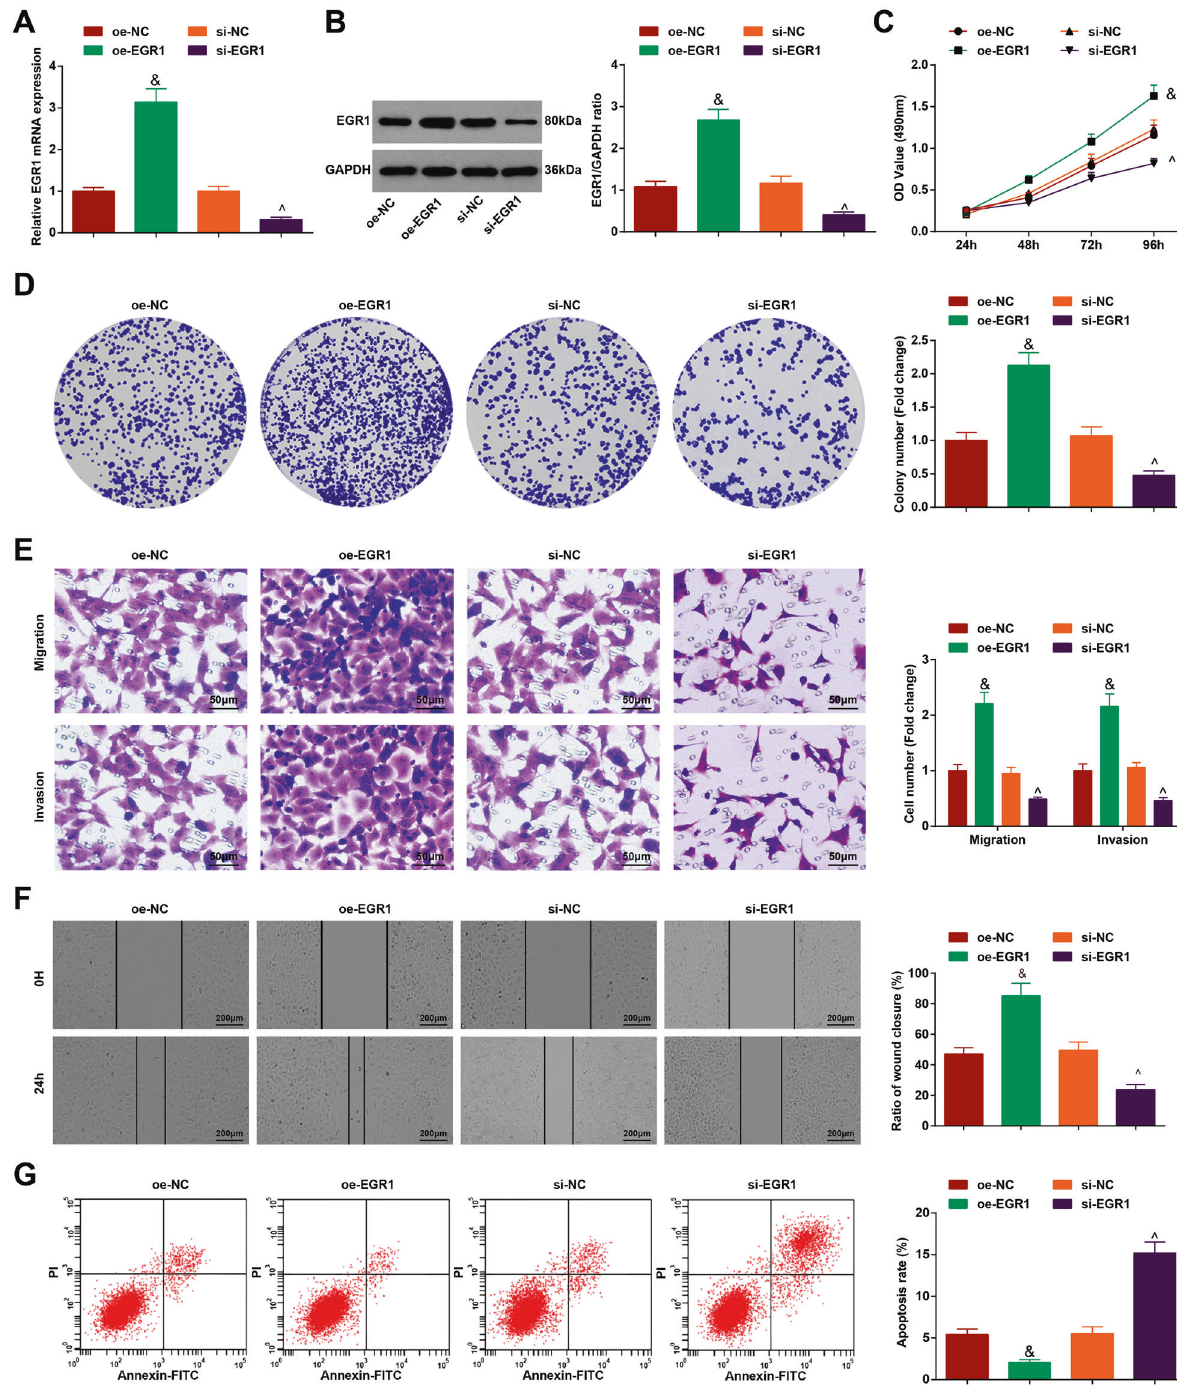
Fig. 4 Silencing EGR1 inhibits HCC progression. A, B EGR1 expression in HCC cells tested by RT-qPCR and western blot analysis after upregulating or downregulating EGR1; C OD value tested by MTT test after upregulating or downregulating EGR1; D Colony-forming ability of HCC cells tested by colony formation assay after upregulating or downregulating EGR1; E Migration and invasion of HCC cells tested by Transwell test after upregulating or downregulating EGR1 (scale bar = 50 μ m); F Migration distance of HCC cells tested by scratch test after upregulating or downregulating EGR1 (scale bar = 200 μ m); G Apoptosis of HCC cells tested by fl ow cytometry after upregulating or downregulating EGR1. N = 3. The data were expressed as mean±standard deviation and compared by one-way ANOVA. & p < 0.05 vs. the oe- NC group; ^ p < 0.05 vs. the si-NC group. Dual-luciferase reporter gene assay antibody overnight. The brown stain on the membrane indicated a positive The target sites of EGR1 and miR-130a were determined by bioinformatics immunoreaction. The percentage of positively stained cells was calculated. websites miRanda, starBase and DIANA. EGR1 3 ’ untranslated region (UTR)- The image was visualized using Nikon ECLIPSE Ti (Fukasawa, Japan) and wild-type (WT) and EGR1 3 ’ UTR-mutant type (MUT) fragments were analyzed with Nikon software.